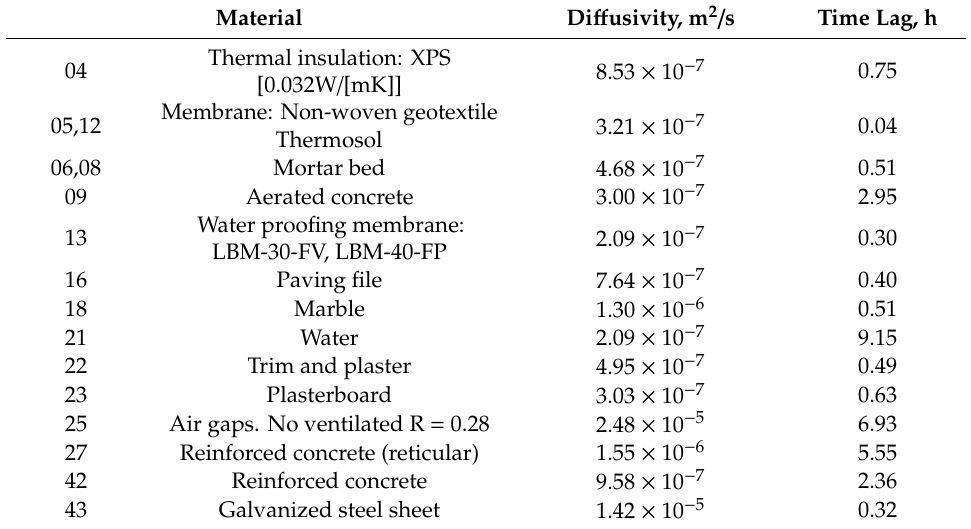
Table 12. Thermal di ff usivity and time lag of the materials composing the roof sections under